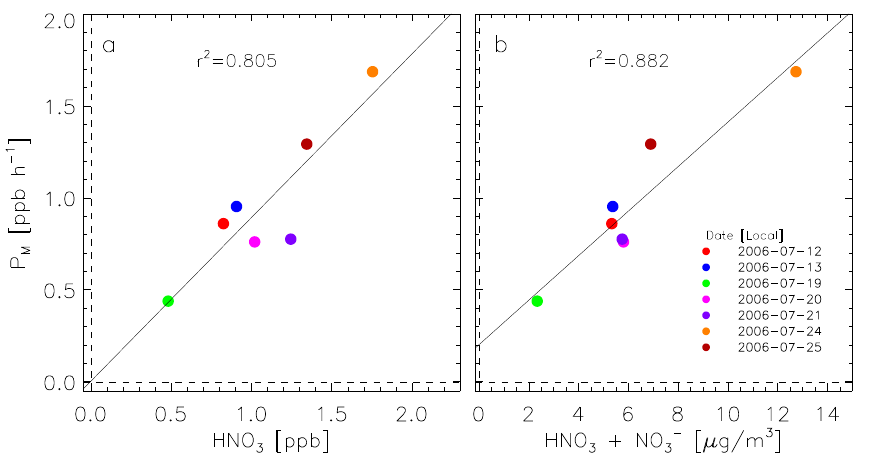
, RH, S aw , and σ a , 532 . 2